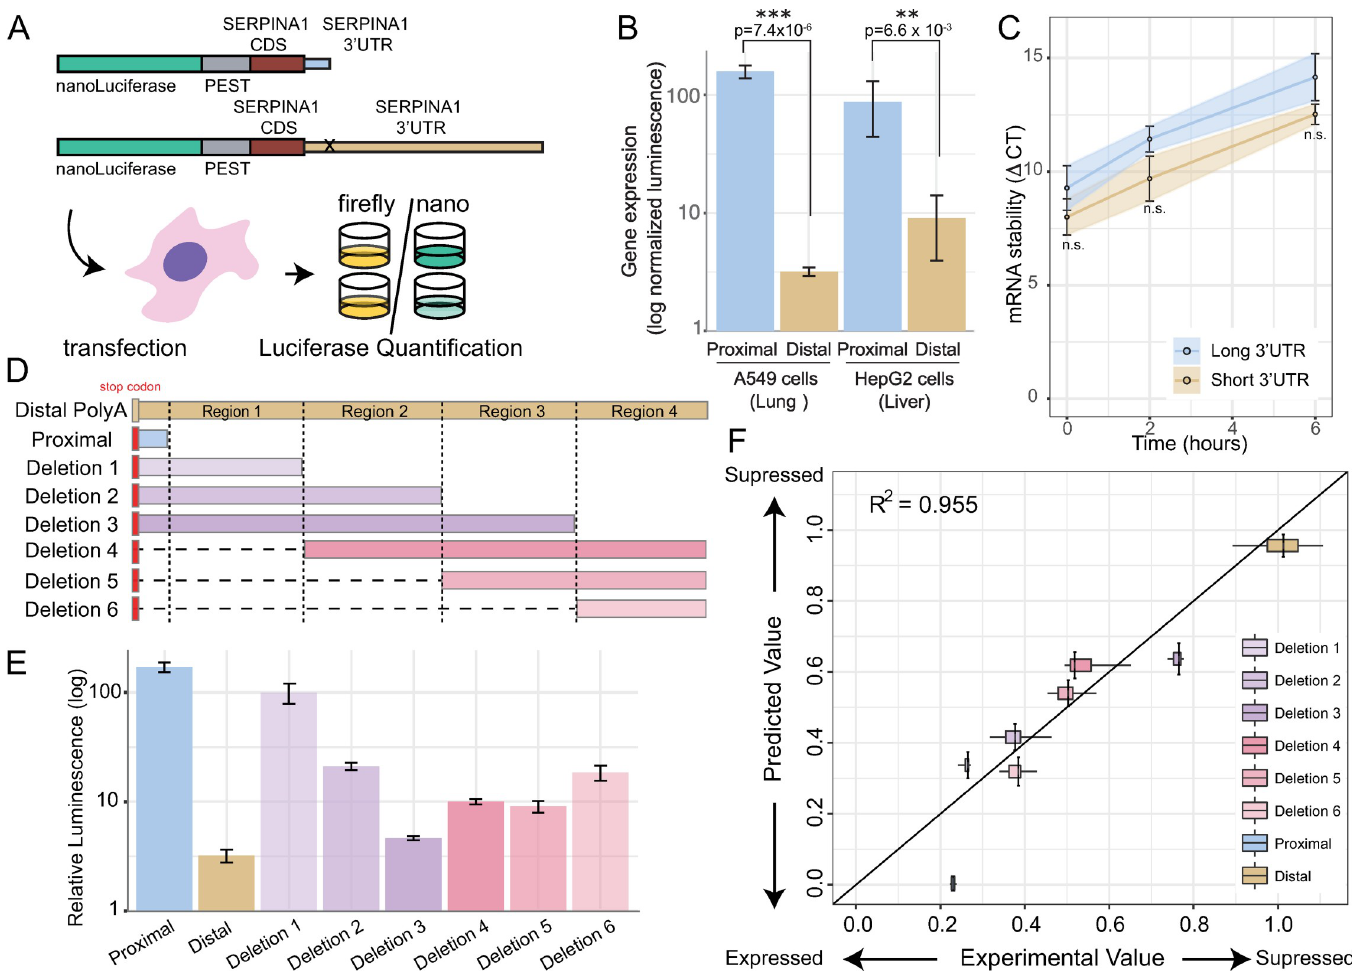
Fig 3. Luciferase reporter and mRNA stability assays to measure the effect of long vs. short 3 0 UTRs. To measure effect on translation efficiency and mRNA stability of the long and short 3 0 UTR sequences we performed a series of luciferase reporter assays. A) Schematic of the luciferase reporter assay, combining a nanoluciferase reporter, PEST domain and the SERPINA1 exon 7 coding sequence upstream of the long and short 3 0 UTRs. The proximal APA site is mutated to inhibit use of this site (indicated with an x on the long construct). These constructs are co-transfected in HepG2 and A549 cell lines with a control firefly reporter and the ratio of nanoluciferase protein to